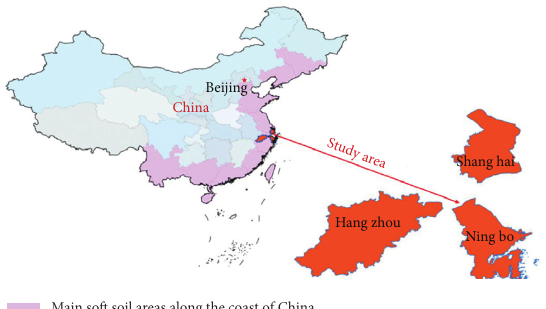
Figure 1: The main soft soil distribution along the coast of China and the soft soil distribution region in this